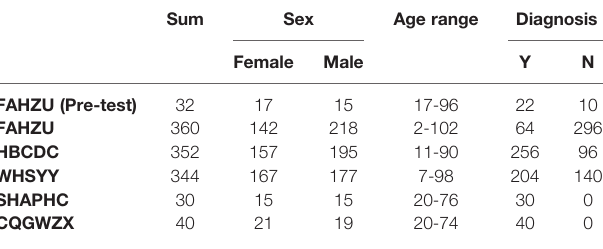
TABLE 1 | Summary of participant information from fi ve